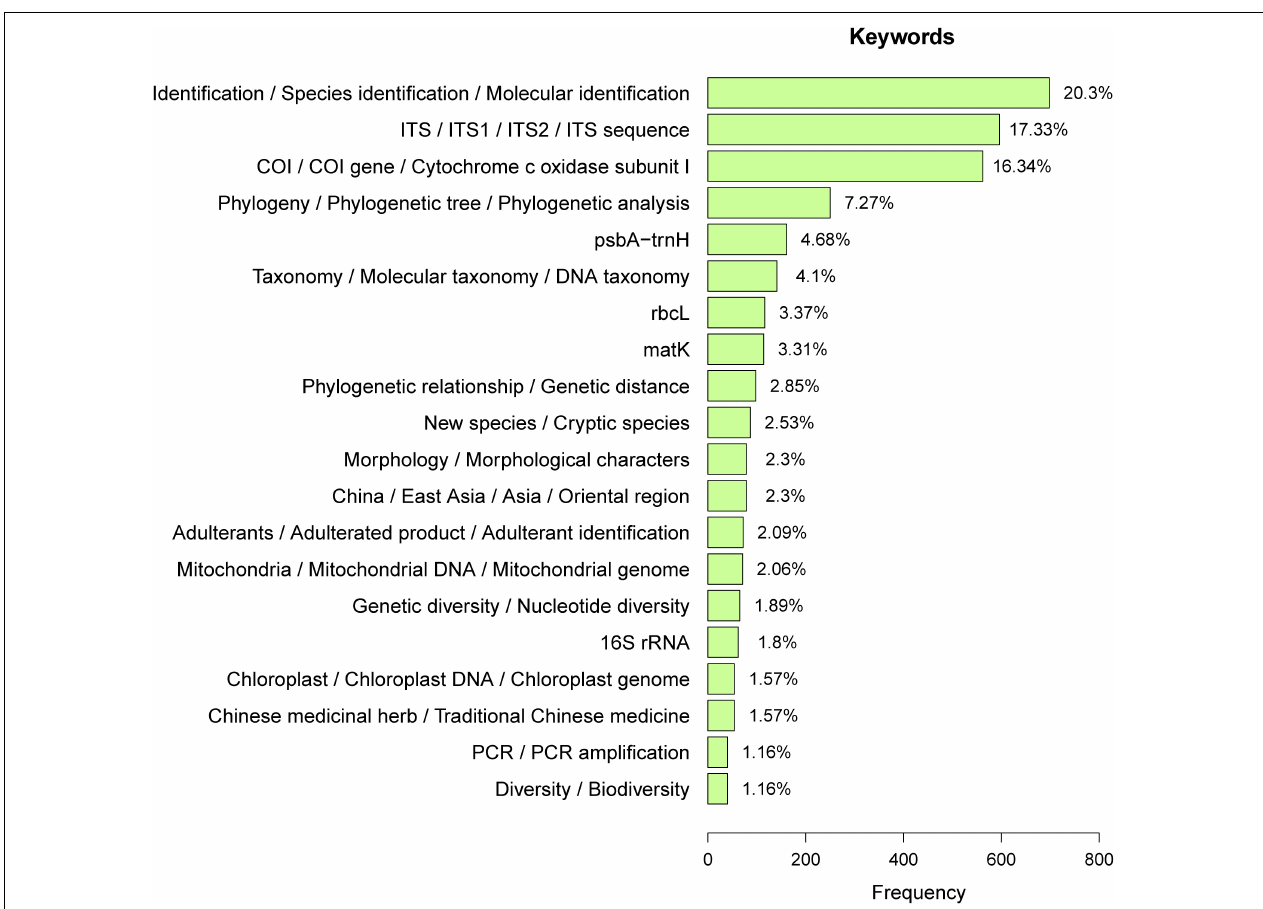
FIGURE 7 | Frequency of key words in DNA barcoding studies published by Chinese researchers. The X axis represents the frequency of various keywords in the search results of all articles, and the Y axis represents similar categories of keywords. Percentages represent the ratio of the frequency of each keyword to the total number of terms in the top 20. There are no terms such as “DNA barcoding,” “DNA barcode,” “DNA barcodes,” and “barcoding” presented here because they are obviously the most frequent ones.